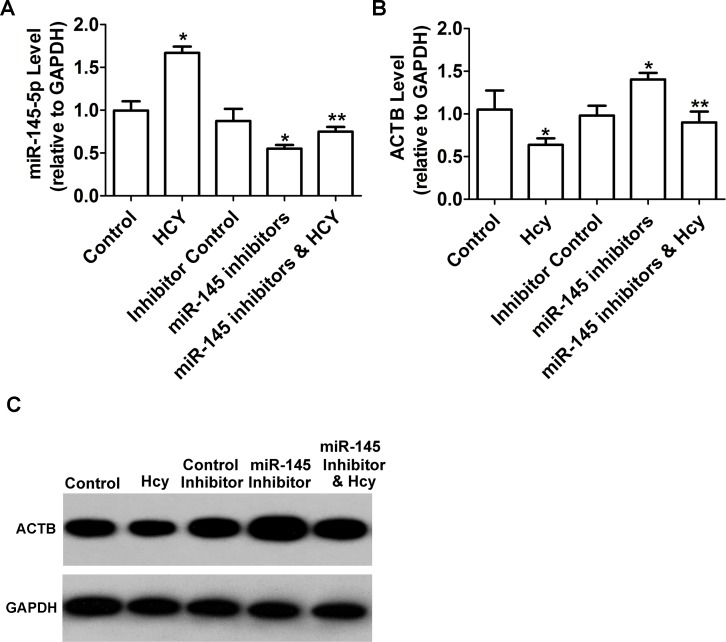
Comparisons of mir-145-5p and ACTB levels in the five groups.(A) Expressionof miR-145-5p were detected by RT-qPCR; (B-C) The mRNA and protein levels of ACTB was detected by RT-qPCR and western blot, respectively. * P<0.05 compared with control group; ** P<0.05 compared with miR-145 inhibitors group.